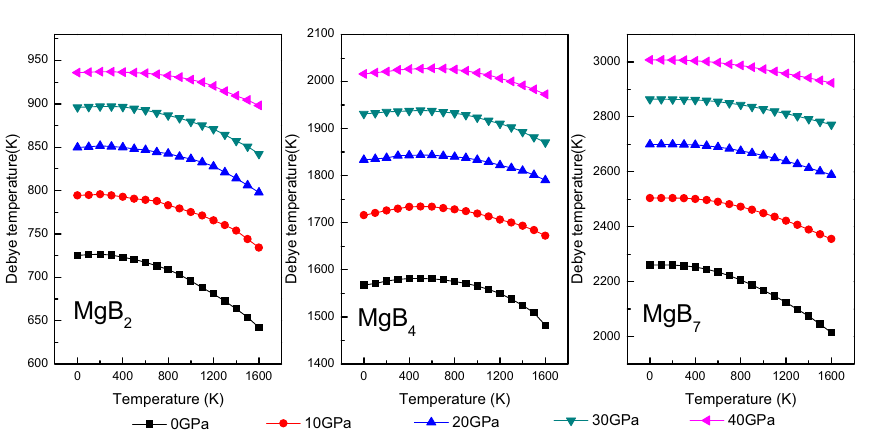
Figure 9. Debye temperature of Mg–B compounds under various pressure and